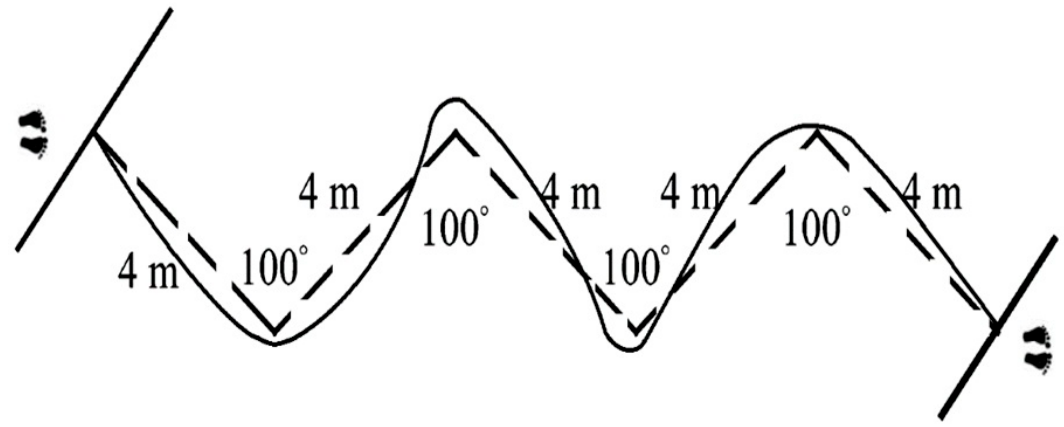
Figure 4. Design of the repeated change-of-direction (RCOD) test.